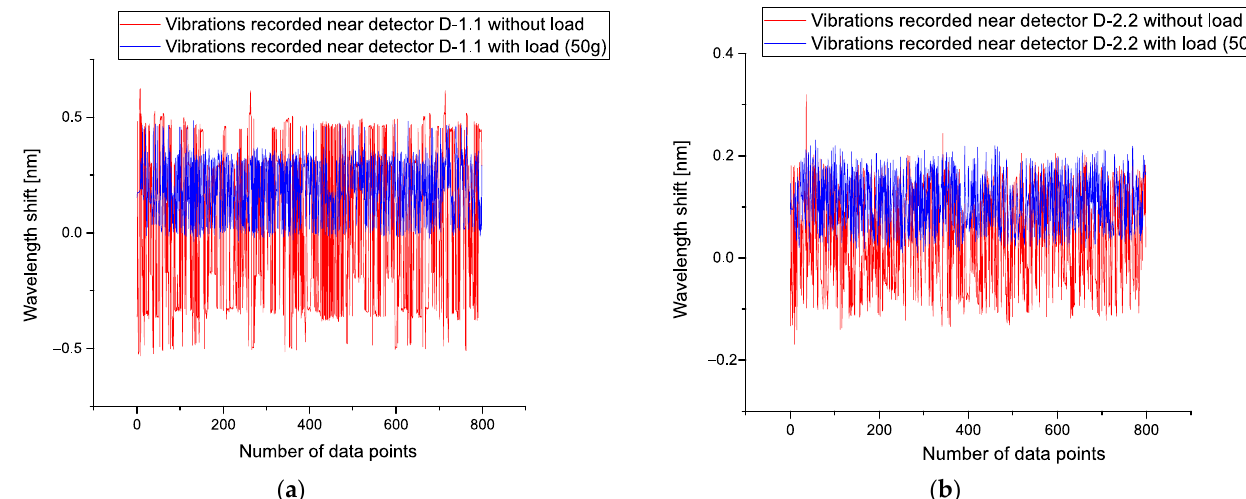
Figure 4. ( a ) This figure shows the level of vibrations without loads (red lines) and with minimal load corresponding to the load equal to 10 g (blue lines). This figure reflects the noise fluctuation for the first detector D-1.1. In order to stress their difference, the same picture Figure 4 ( b ) is placed on the right-hand side for detector D-2.2 (with load 10 g) and without load (red lines), correspondingly. For other detectors, the obtained pictures look the same and therefore they are omitted.